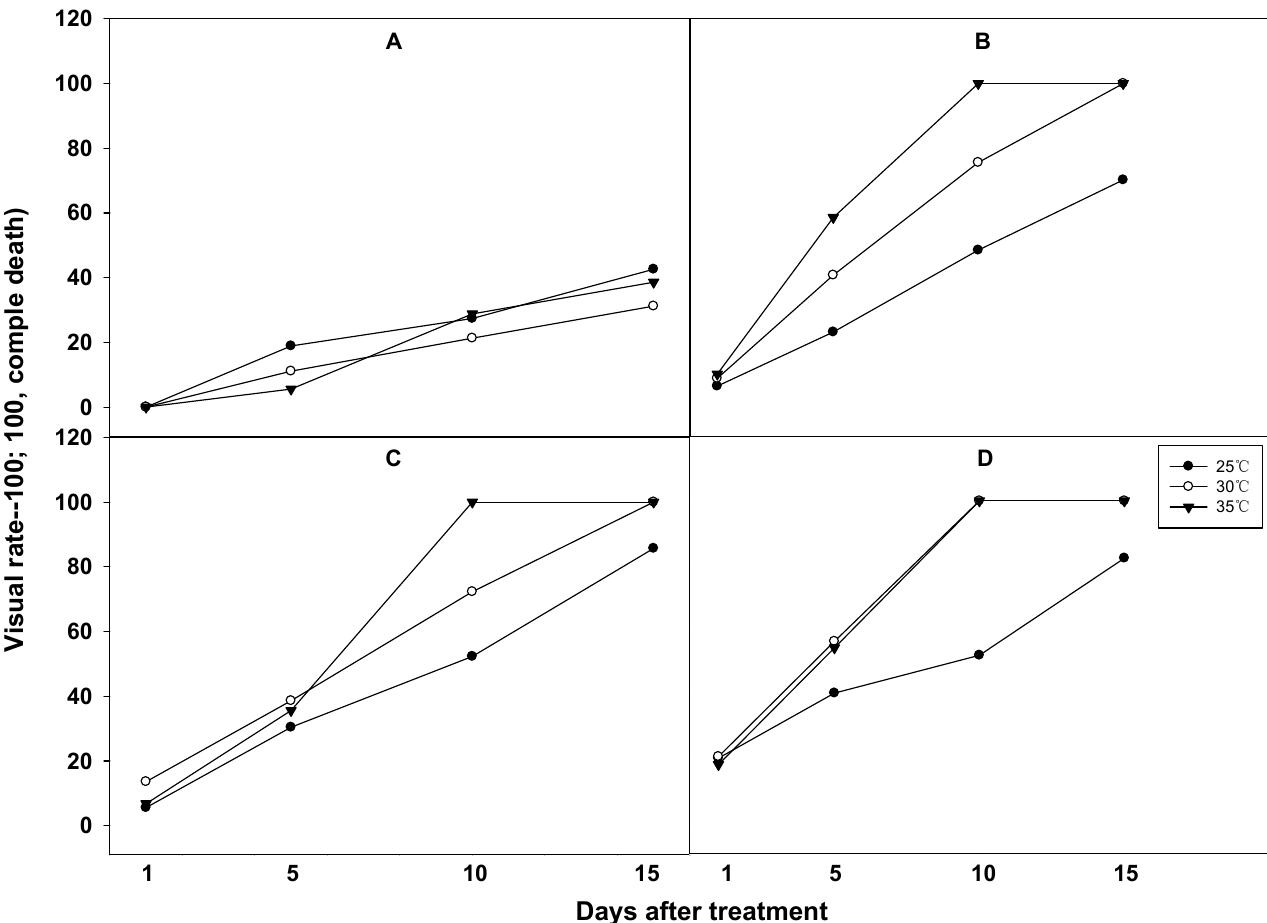
Figure 8. Visual rate (0–100, 100, complete death) of A. patulus in response to foliar herbicides ( A . glyphosate isopropylamine; B . glufosinate-ammonium; C . bentazone; D . mecoprop) at each recommendation rate under different temperatures in a growth chamber.